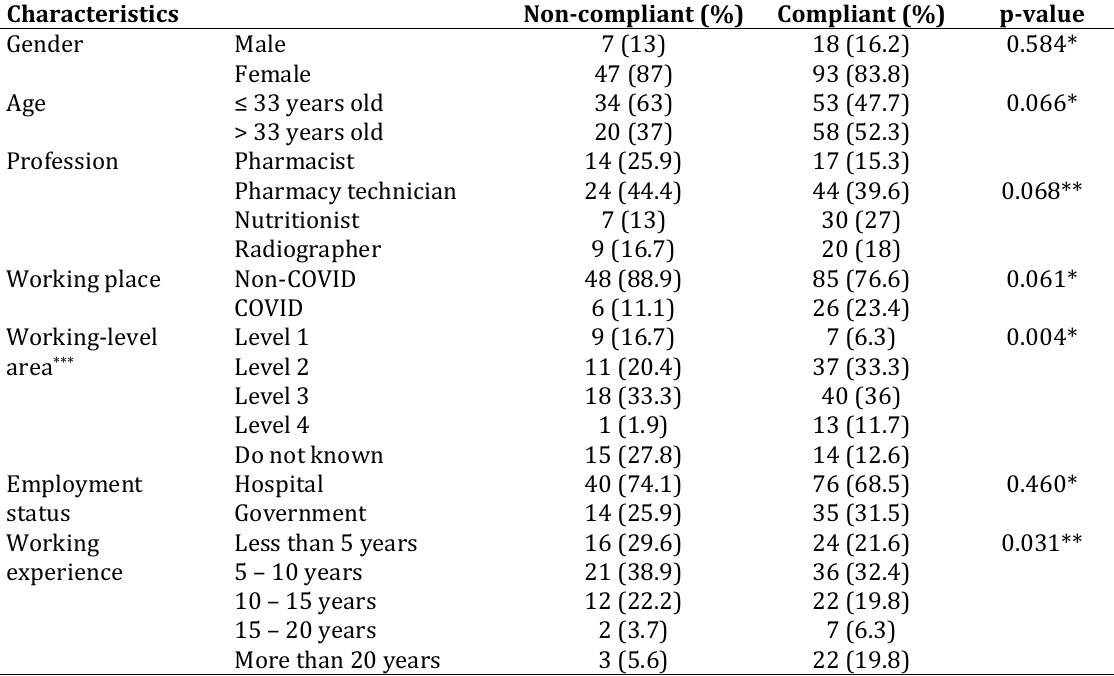
Table IV. Analysis between participant’s characteristics and compliance in using PPE